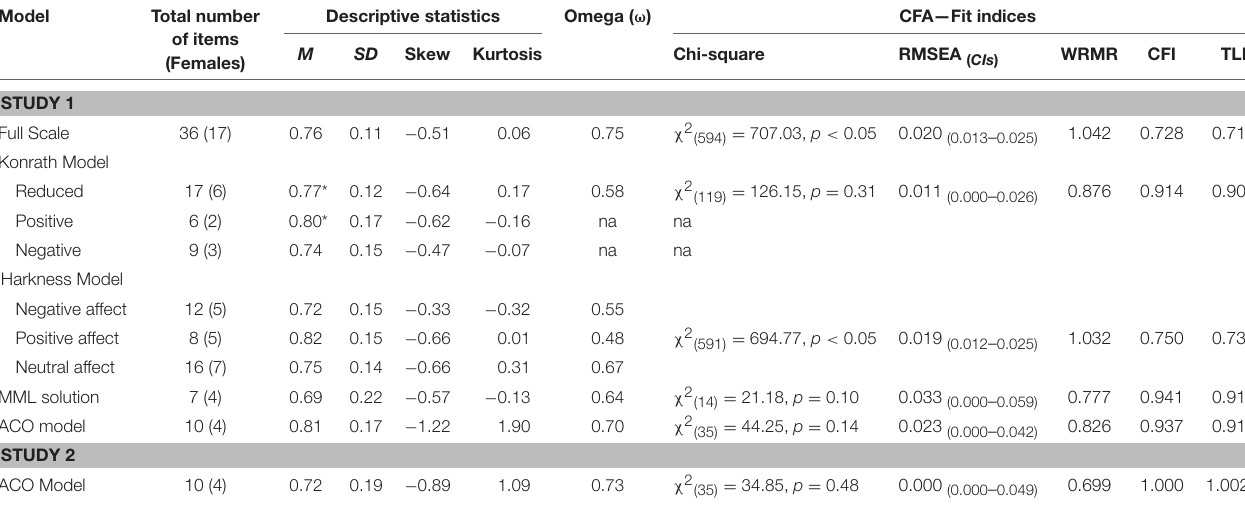
TABLE 5 | Study 1 and 2: Comparison of possible short-form and subscale solutions.